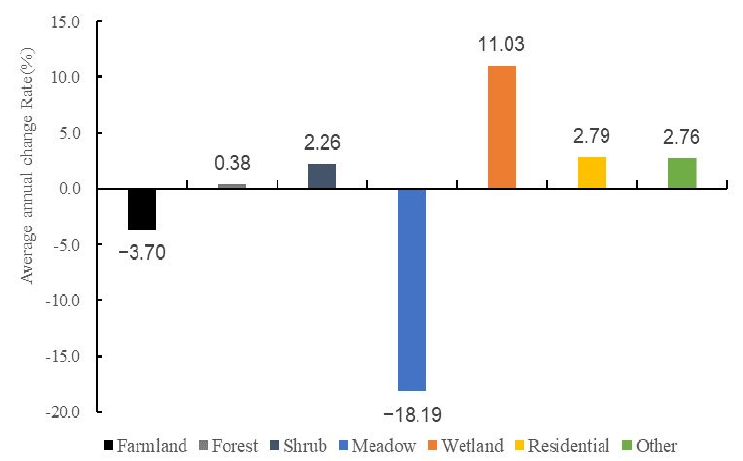
Figure 7. Average annual change rate of ESV for different land cover types. As seen from Table 7, the ESV of forests and wetlands have always accounted for a large proportion, and the number has continued to grow. The total ESV in 2015 was 2878.38 × 108 ￥ , and in 2020 it was 3109.16 × 108 ￥ , an increase of 230.78 × 108 ￥ in five years, with a change rate of 8.02%. The overall value of ecological services changed sig ‐ nificantly, showing an upward trend. During the study period, the areas of forest, shrub, wetland, and other land all show an increasing trend, and the ESV also increases accord ‐ ingly. Table 7. The Area and ESV of Major Land Cover Types in the SAHMHER. Type Year